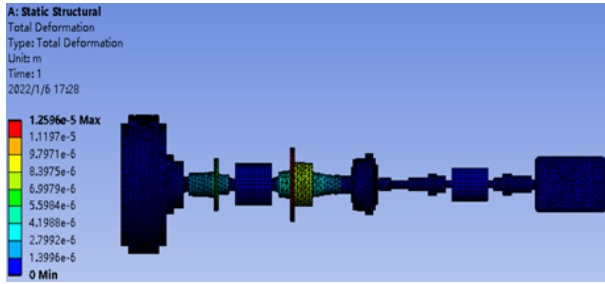
Figure 4. Simulation diagram of cloud displacement in y direction of transmission